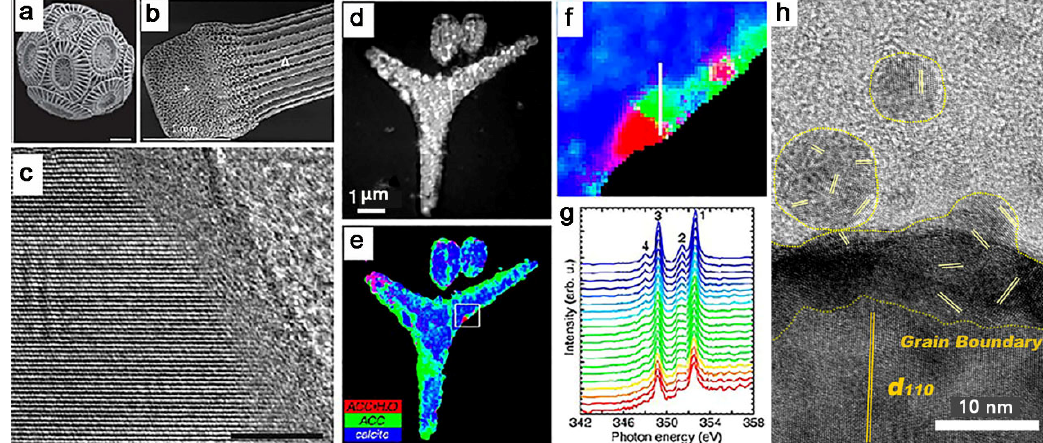
Figure 6. ( a ) SEM image of Emiliania huxleyi (Skeffington and Scheffel, 2018). ( b ) SEM of small spine. Reproduced with permission [81]. Copyright 2018, American Chemical Society. ( c ) HRTEM micrograph of a selected surface area of the single crystalline aragonite nacre platelets. Reproduced with permission [84]. Copyright 2005, National Academy of Science. ( d ) Component mapping in 48 h spicules, at the prism developmental stage, analyzed within 24 h of extraction from the embryo. X-ray absorption near-edge structure spectroscopy and photoelectron emission microscopy (XANES-PEEM) image of three spicules embedded in epoxy. ( e ) Red, green, and blue (RGB) map displaying the results of component mapping. The box indicates the region magnified in f. ( f ) Zoomed-in portion of the RGB map in ( e ), where each 15 nm pixel shows a different color. Pure phases are R, G, or B, whereas mixed phases are cyan, magenta, or yellow. ( g ) Sequence of 20 XANES spectra extracted from 15 nm adjacent pixels along the white line in ( f ). The color-coding is the same as that used in ( e , f ). Notice that the white line in f runs from the outer rim of the spicule (red), passing through orange, yellow, green, cyan, and finally blue, toward the crystalline center of the spicule. Correspondingly, moving from bottom to top across the spectra in ( g ), one can see peak-2 growth leading, and peak-4 emergence and growth lagging. Reproduced with permission [85]. Copyright 2012, National Academy of Science. ( h ) Attachment of nanocrystals onto the vaterite surface at early stages. Reproduced with permission [30]. Copyright 2016, Wiley-VCH.